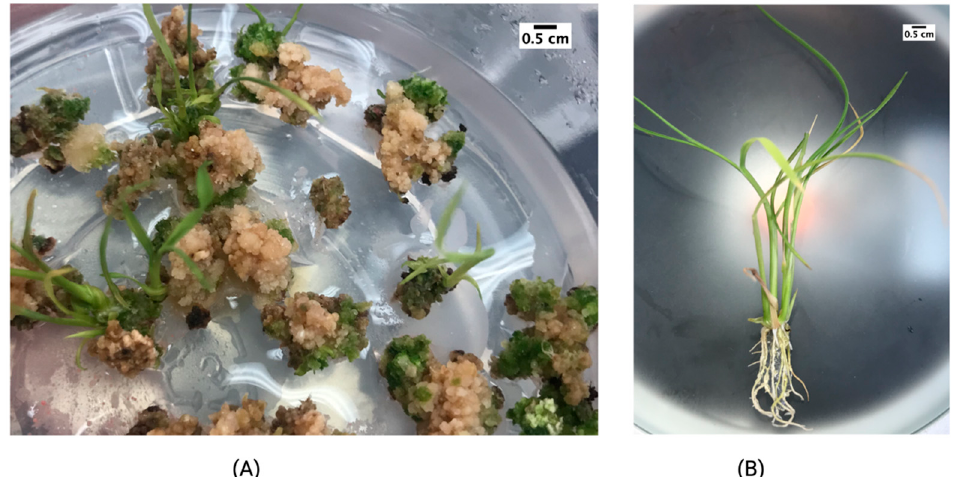
Figure 4. Response of 60 Gy irradiated calli Lazarroz FL cultivar after ( A ) 45 days and ( B ) 60 days of culture on regeneration medium.